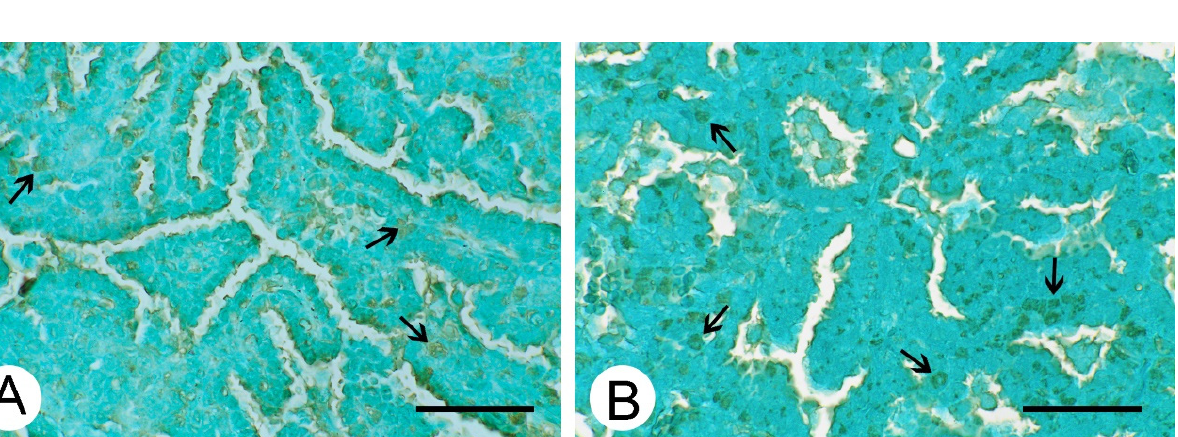
Figure 7. Proliferation index. The index indicated that between groups II and IV, no statistical differ- ence was observed. N = 10, values expressed as mean percentage of PCNA positive nuclei ± SEM (two-tailed Student’s t -test with Welch’s correction). No statistically significant differences were observed.